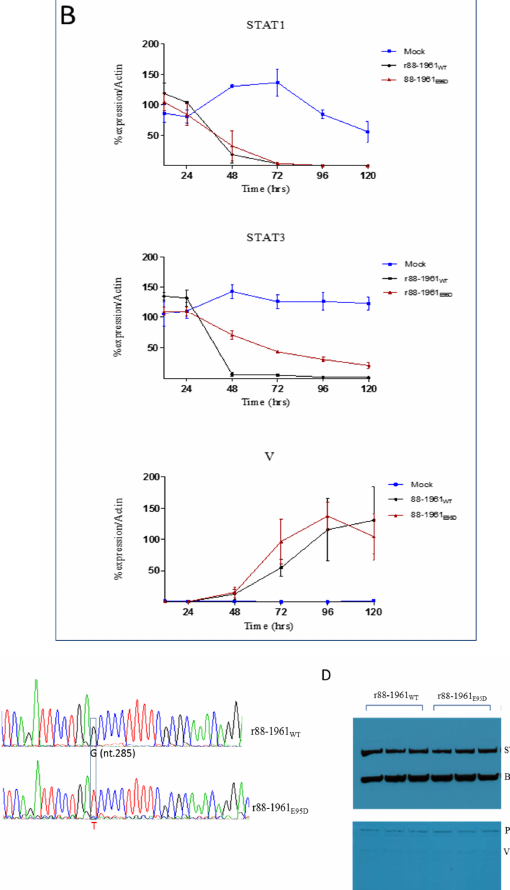
Figure 3. Degradation of STAT proteins in vitro and in vivo (r88-1961 WT and r88-1961 E95D ). ( A ) Confluent monolayers of Vero cells were infected with r88-1961 WT and r88-1961 E95D at an MOI of 1.0. Cell lysates prepared at the times indicated were subjected to SDS-PAGE and Western blot. The blots were probed with anti-STAT1, anti-STAT3, anti-B-actin, and anti-mumps P / V antibodies. Although no significant di ff erences were observed in the degradation of STAT1, degradation of STAT3 was noticeably delayed in cells infected with r88-1961 E95D versus those infected with r88-1961 WT . Reduced V E95D activity corresponded with a concomitant increase in V E95D versus V WT expression. ( B ) To quantify the data shown in the Western blots in panel (A), a series of Western blots were performed from lysates collected longitudinally. The expression kinetics of STAT1, STAT3 and V were evaluated in three independent experiments and band intensities quantified using the Image J program. The data represents mean values ± standard error of the mean and rea ffi rm the findings observed in the individual blot. ( C ) Maintenance of the wild type V gene nucleotide (G) in r88-1961 WT and the presence of the engineered substitution (T) in r88-1961 E95D was confirmed in Vero cells infected with r88-1961 WT and r88-1961 E95D at 120 h post inoculation. The sequence was confirmed independently in triplicate infections per virus variant. ( D ) Newborn rats inoculated intracerebrally in triplicate with r88-1961 WT and r88-1961 E95D were euthanized on day 3 post inoculation. The brain lysates were subjected to SDS-PAGE and western blot. The blots were probed with anti-STAT3 and anti-B-actin (top panel) and anti-P / V (bottom panel) antibodies. Given that only 1% of brain cells are infected by MuV, no di ff erences were observed in STAT3 levels in vivo between rats infected with r88-1961 E95D versus r88-1961 WT . Note, P / V bands are present, but faint (bottom panel, all